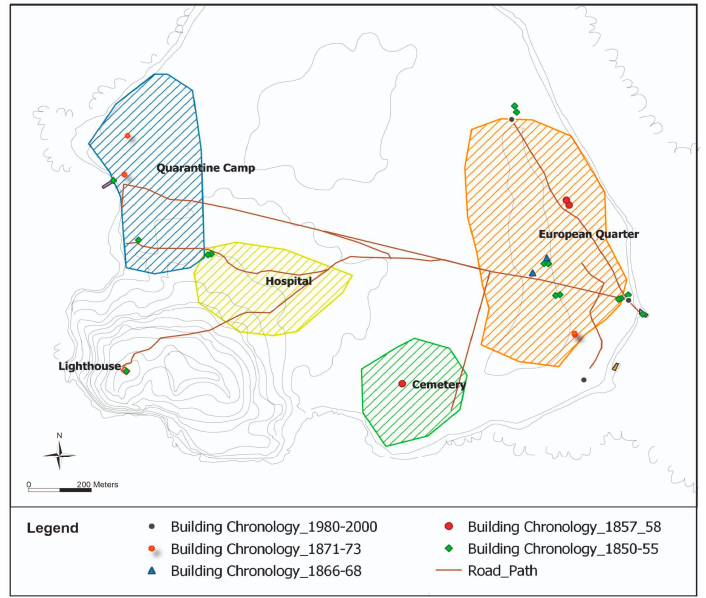
Figure 8. The quarantine station quarters and chronology of documented buildings.